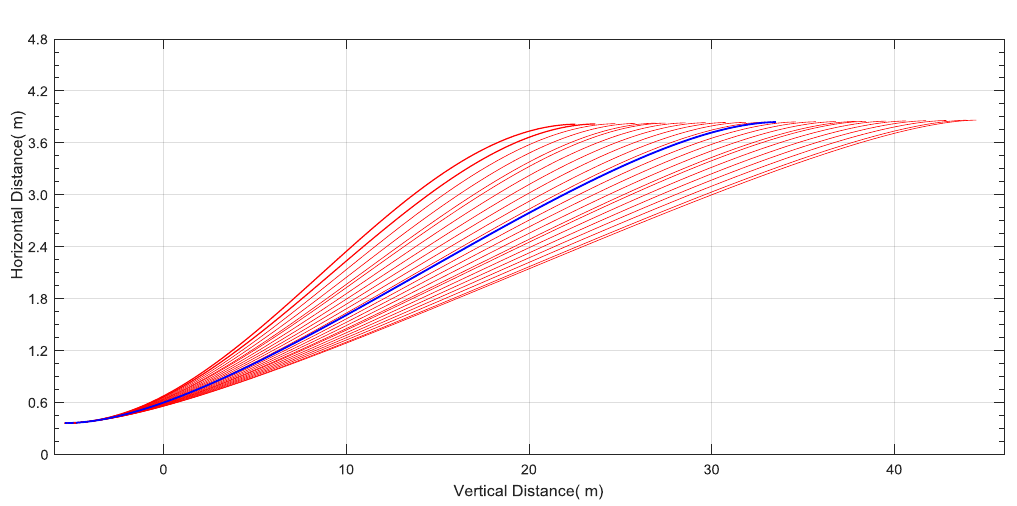
Figure 6. Trajectory candidates, which are represented with red lines, and the selected ideal trajectory, which is represented with a blue line. The selection of the ideal trajectory makes a balance of timeliness and driving comfort.